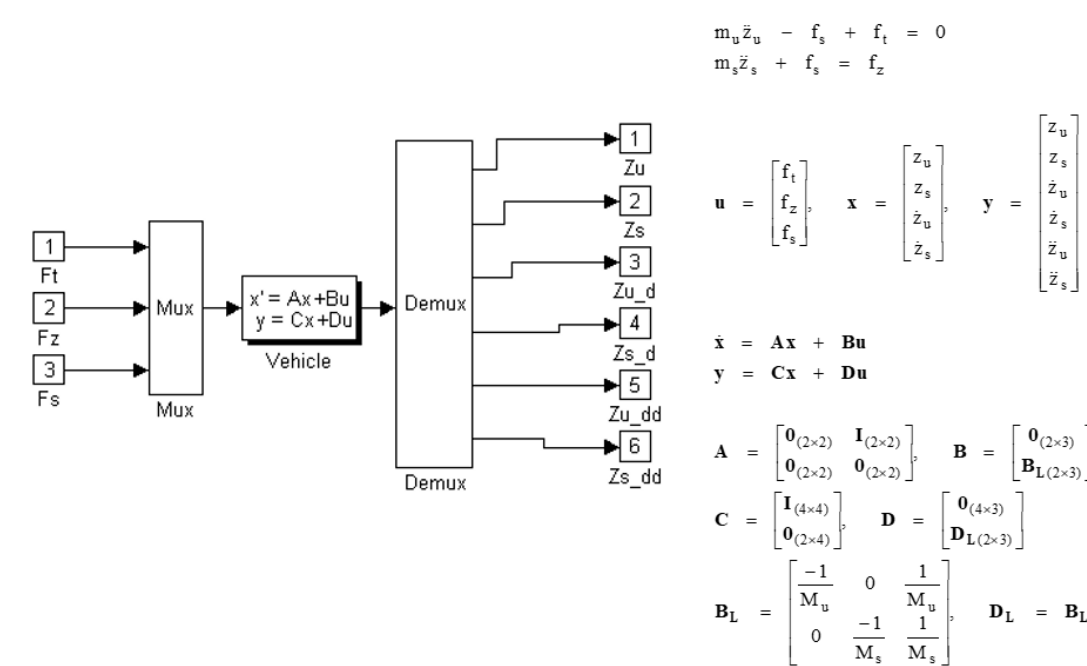
Figure A1. Quarter car model using the simulation modules.